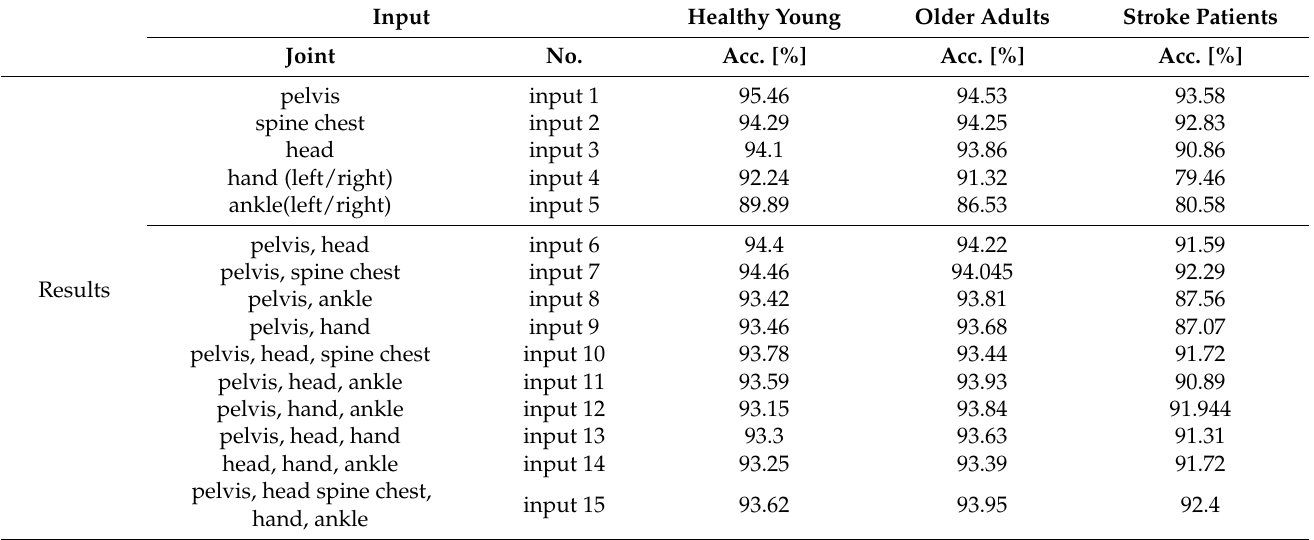
Table 2. Comparison results of TUG subtask segmentation accuracy of joints closest to COG.